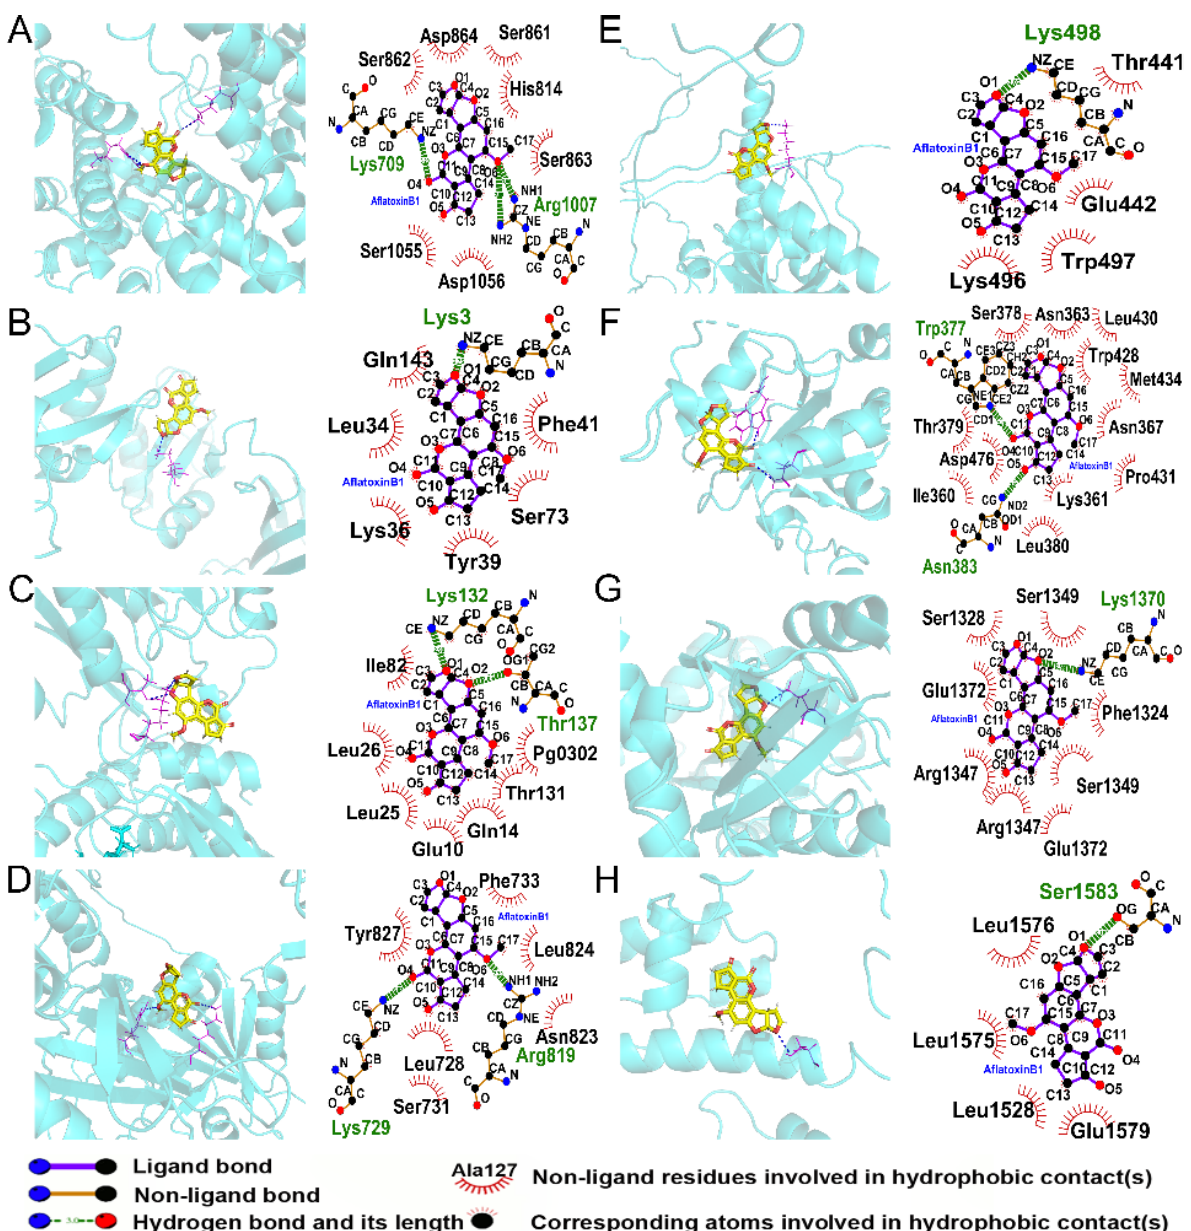
Figure 10. The interactions between AFB1 and m6A regulators of ( A ) VIRMA, ( B ) IGF2BP3, ( C ) METTL5, ( D ) RBM15B, ( E ) YTHDF3, ( F ) YTHDC1, ( G ) YTHDC2, and ( H ) ZC3H13.